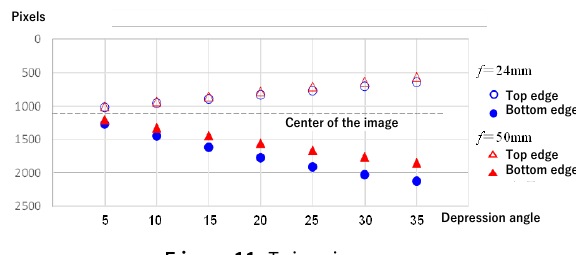
Figure 11 . Trimming